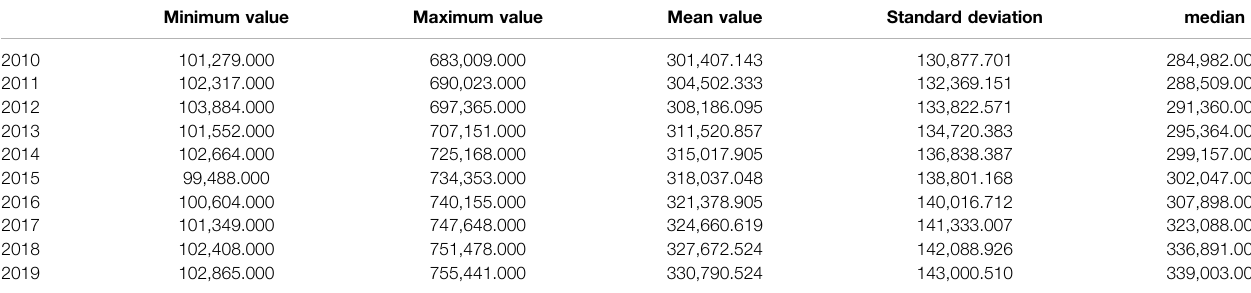
TABLE 1 | The descriptive statistics of population (unit: people).